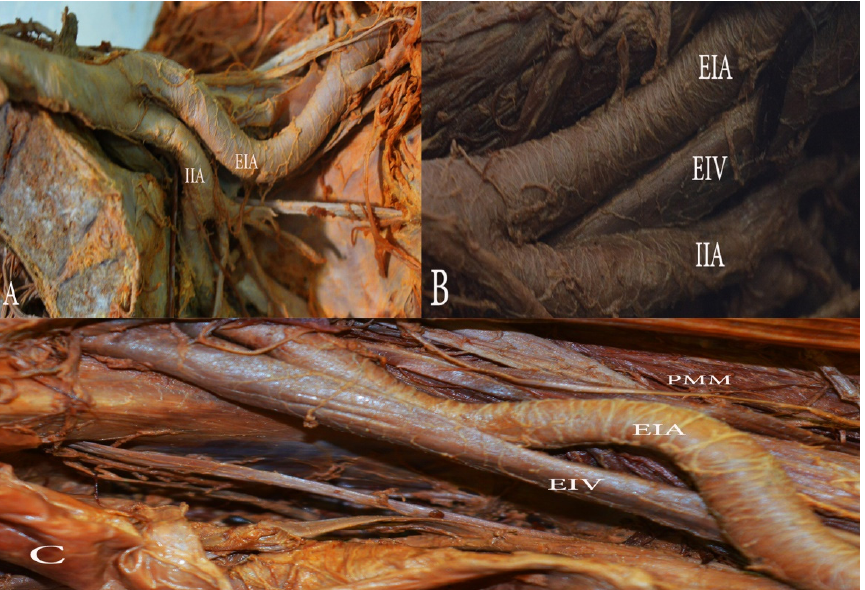
Figure 8 . Morphological variations of the external iliac artery (EIA). ( A ) The EIA with an inward loop in the left hemipelvis. ( B ) The EIA with a gentle inward loop in the left hemipelvis. (C) ’S’ shaped EIA in the right hemipelvis. EIA—external iliac artery, EIV—external iliac vein, IIA—internal iliac artery, PMM—psoas major muscle.